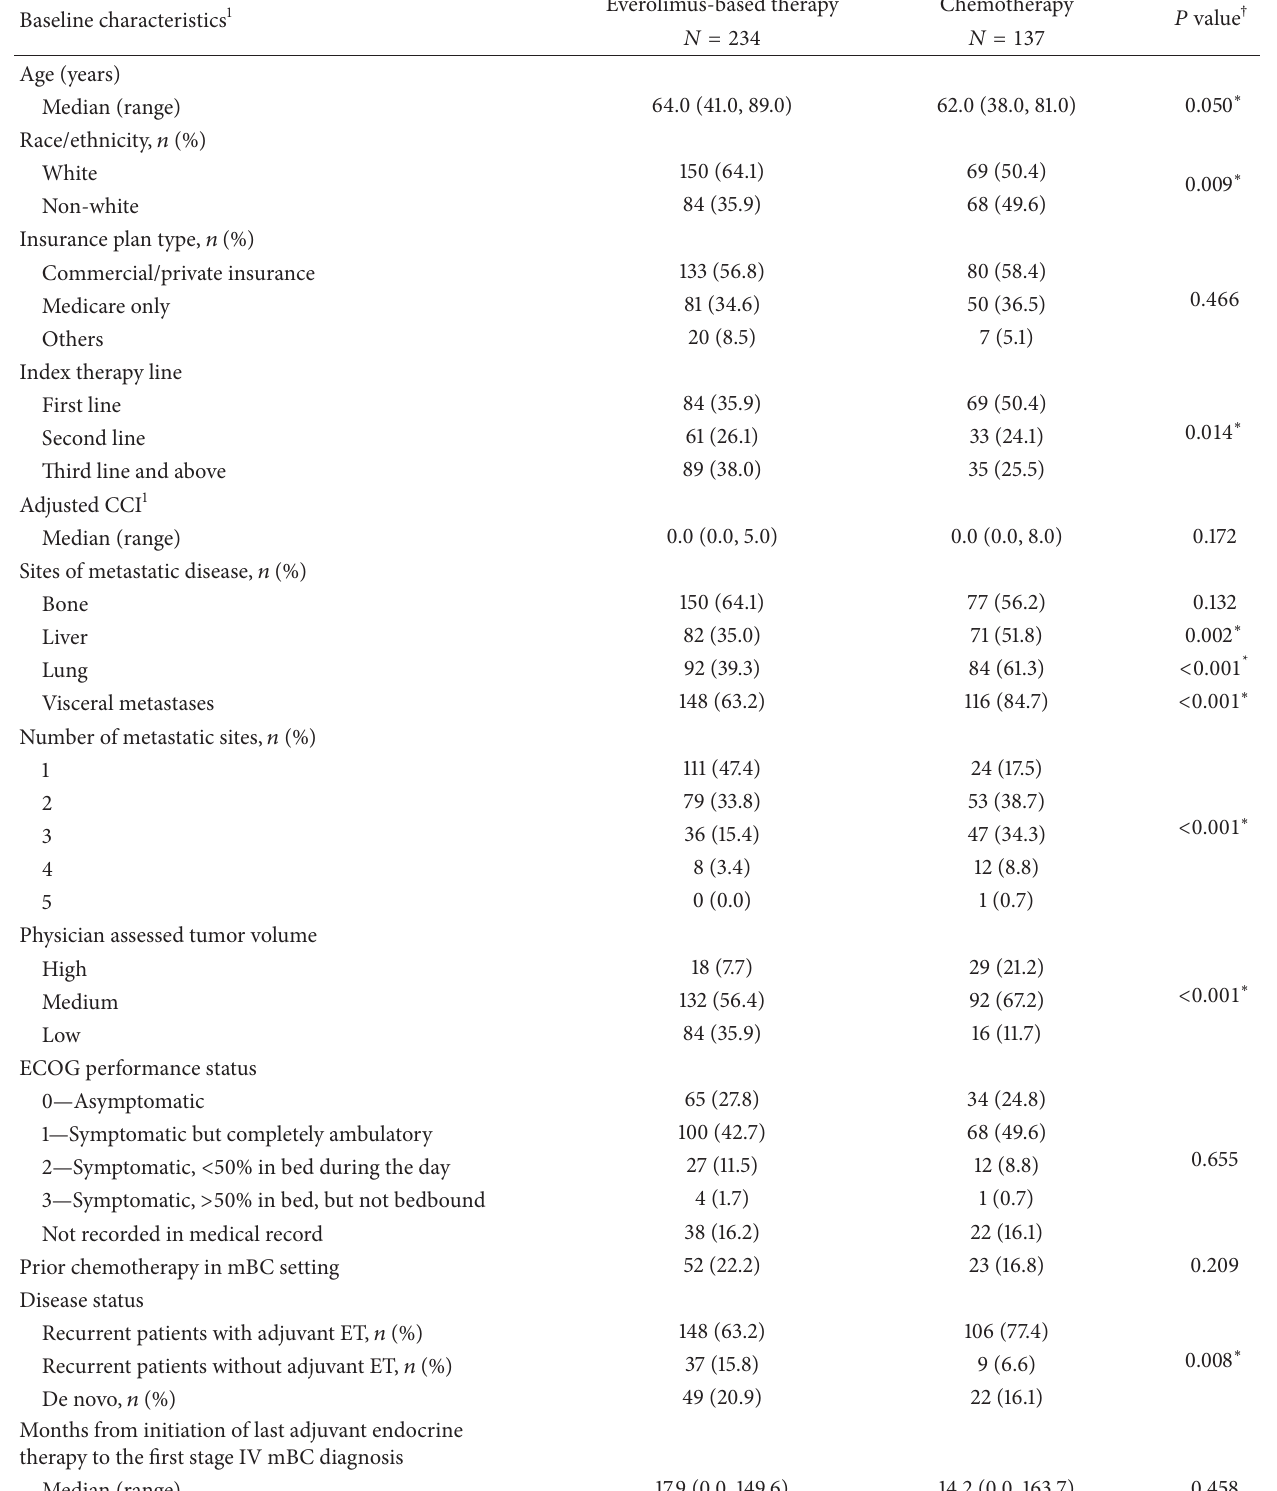
Table 1: Comparison of patient baseline characteristics between everolimus-based therapy and